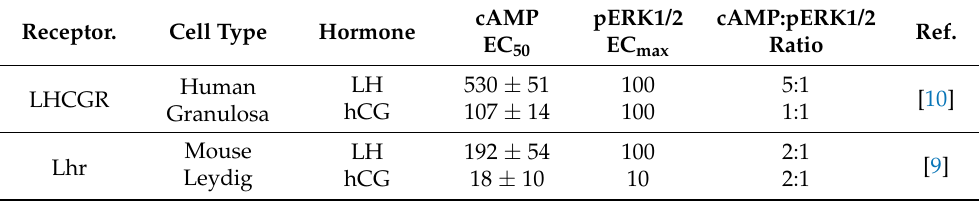
Table 1. Luteinizing hormone (LH) and human chorionic gonadotropin (hCG) 50% effective concen- trations (EC 50 ), and maximal effective concentrations (EC max ) for cyclic adenosine monophosphate (cAMP) and phosphorylated extracellular signal-regulated kinases 1/2 (pERK1/2) activation (pM; means ± SEM; n = 3–5). LHCGR = LH/hCG receptor; Lhr = the murine receptor; Ref. = reference.